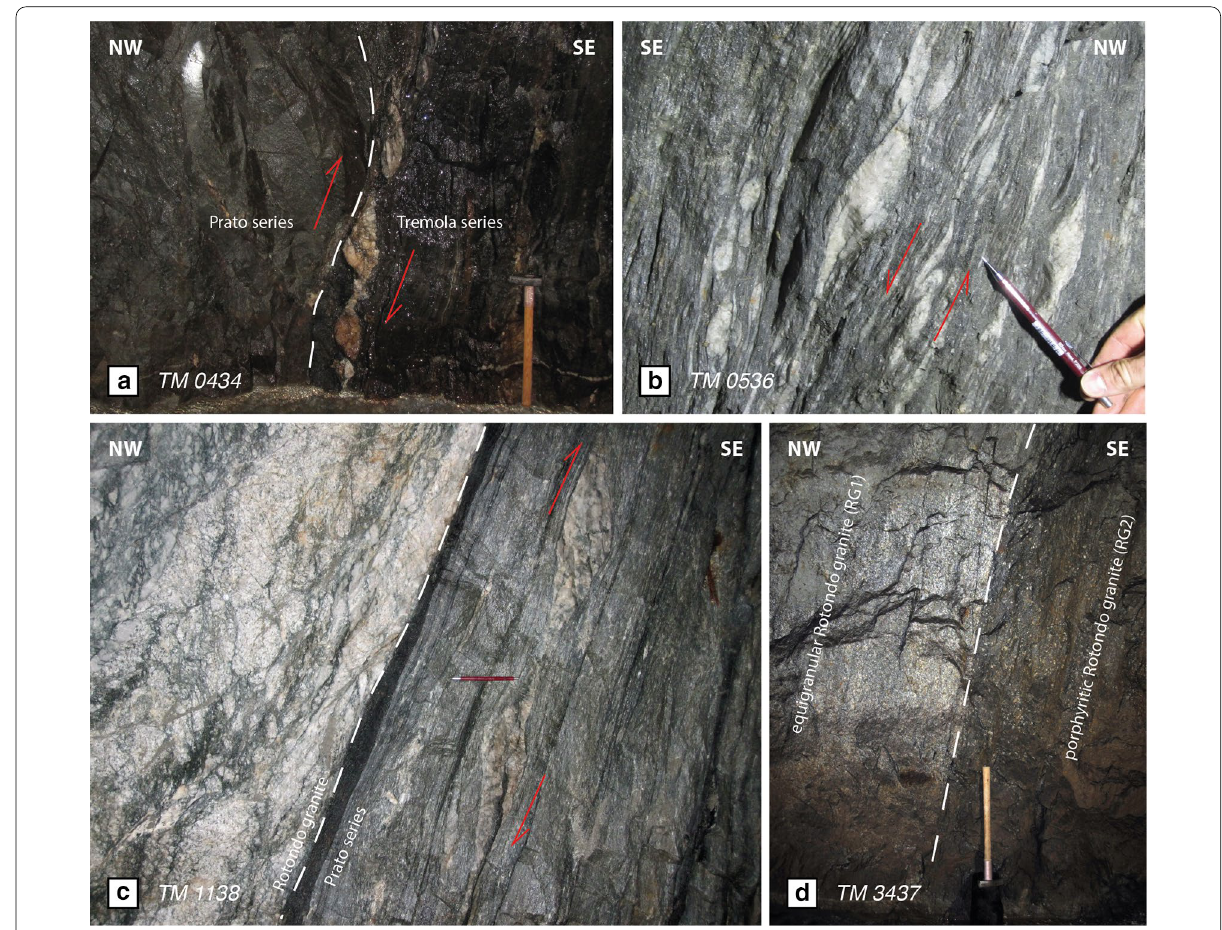
Fig. 5 Field photographs. Italic numbers correspond to tunnel meter (TM) where the images were taken. This is also valid for subsequent figures with field photographs or photomicrographs and will no longer be mentioned. a Contact between Tremola series in the SE and Prato series in the NW, hammer for scale. b Folded and sigmoidal quartz aggregates indicating top-to-south shear sense (upward movement of the northern block) in the Prato series, pencil for scale. c Contact between Prato series in the SE and Rotondo granite in the NW. The Rotondo granite consists at the contact to the Prato series of an approximately 5 m wide zone of highly deformed granite. Pencil for scale. d Contact between the porphyritic variety of the Rotondo granite (RG2) in the SE and the equigranular variety of the Rotondo granite (RG1) in the NW. Note that the RG2 is relatively strongly sheared at the contact and that the RG2 further to the SE is not as dark as in this photograph. Hammer for